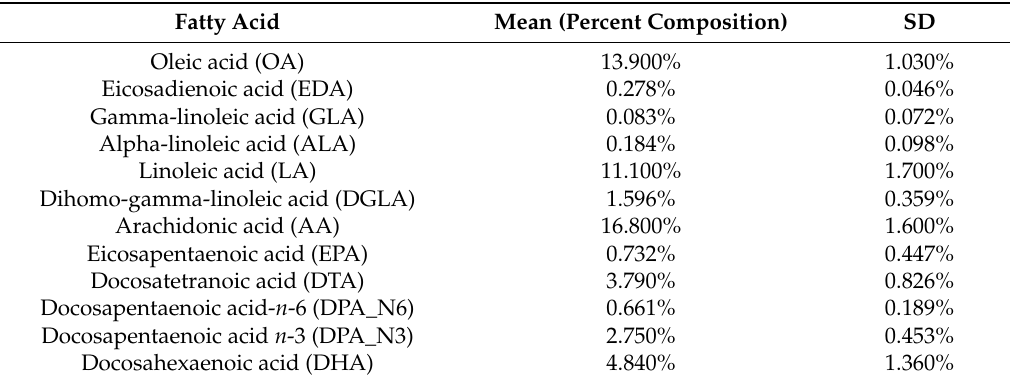
Table 1. Summary of the 12 red blood cell (RBC) fatty acids (FAs) measured by the Framingham Heart Study (FHS) and considered in our